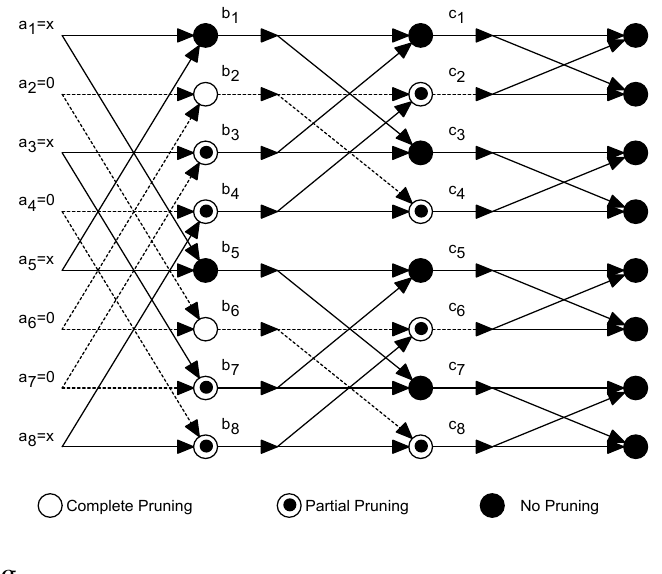
Figure 9. An example FFT butterfly structure with